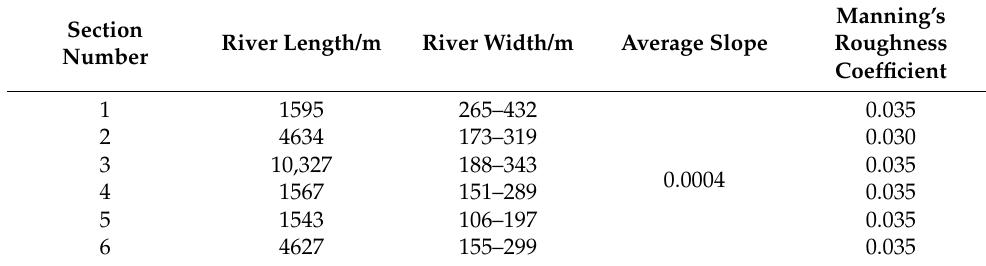
Figure 5. Boundary conditions for the upstream entrance: ( a ) water flow at Tribal Hatchery and the downstream exit, ( b ) water level at Klockmann Ranch. Table 6. Basic information of the Kootenai river.